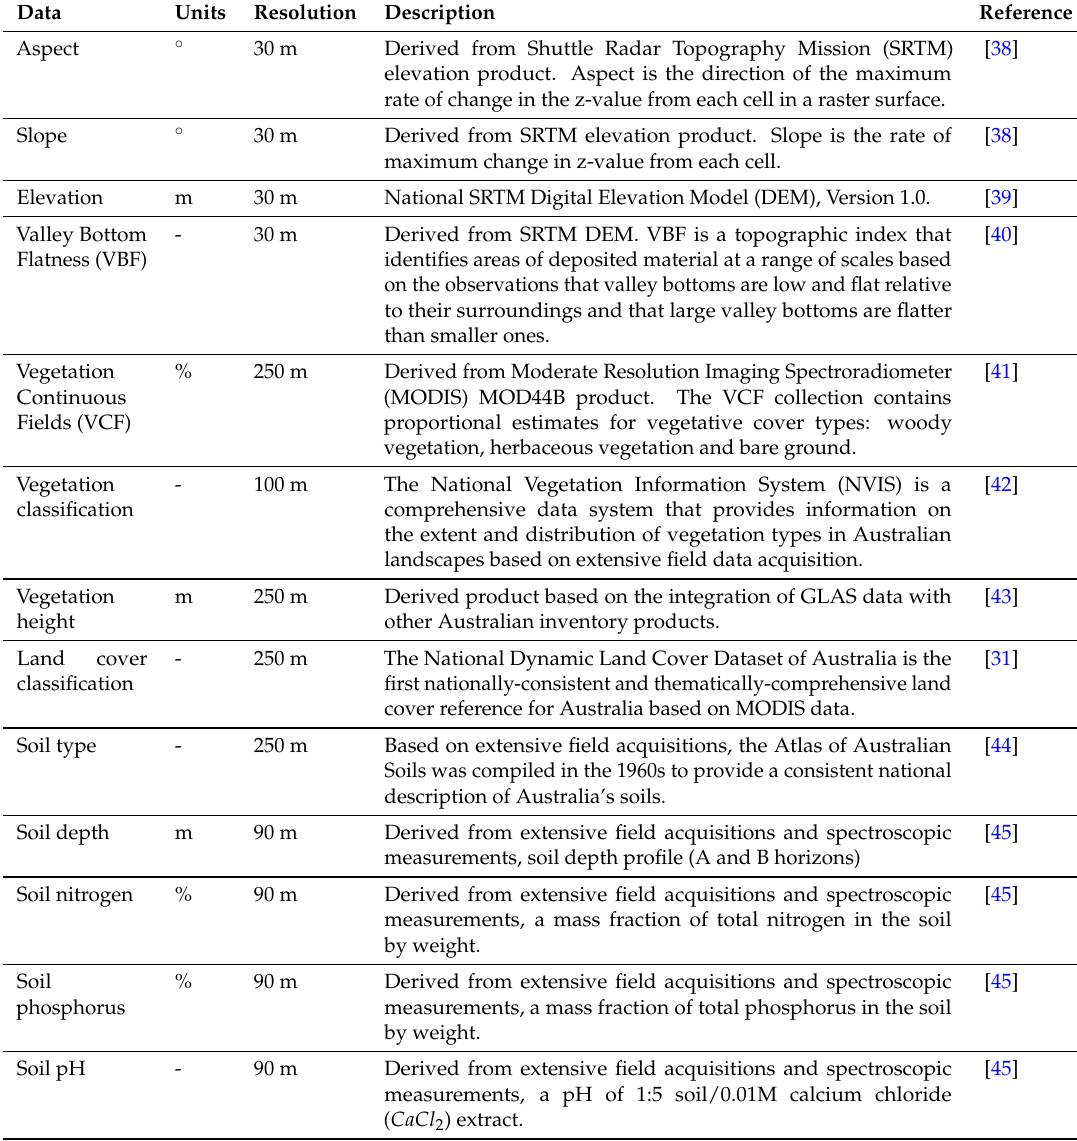
Table 1. Summary of predictor attributes used in testing the sensitivity of GLAS GF scaling